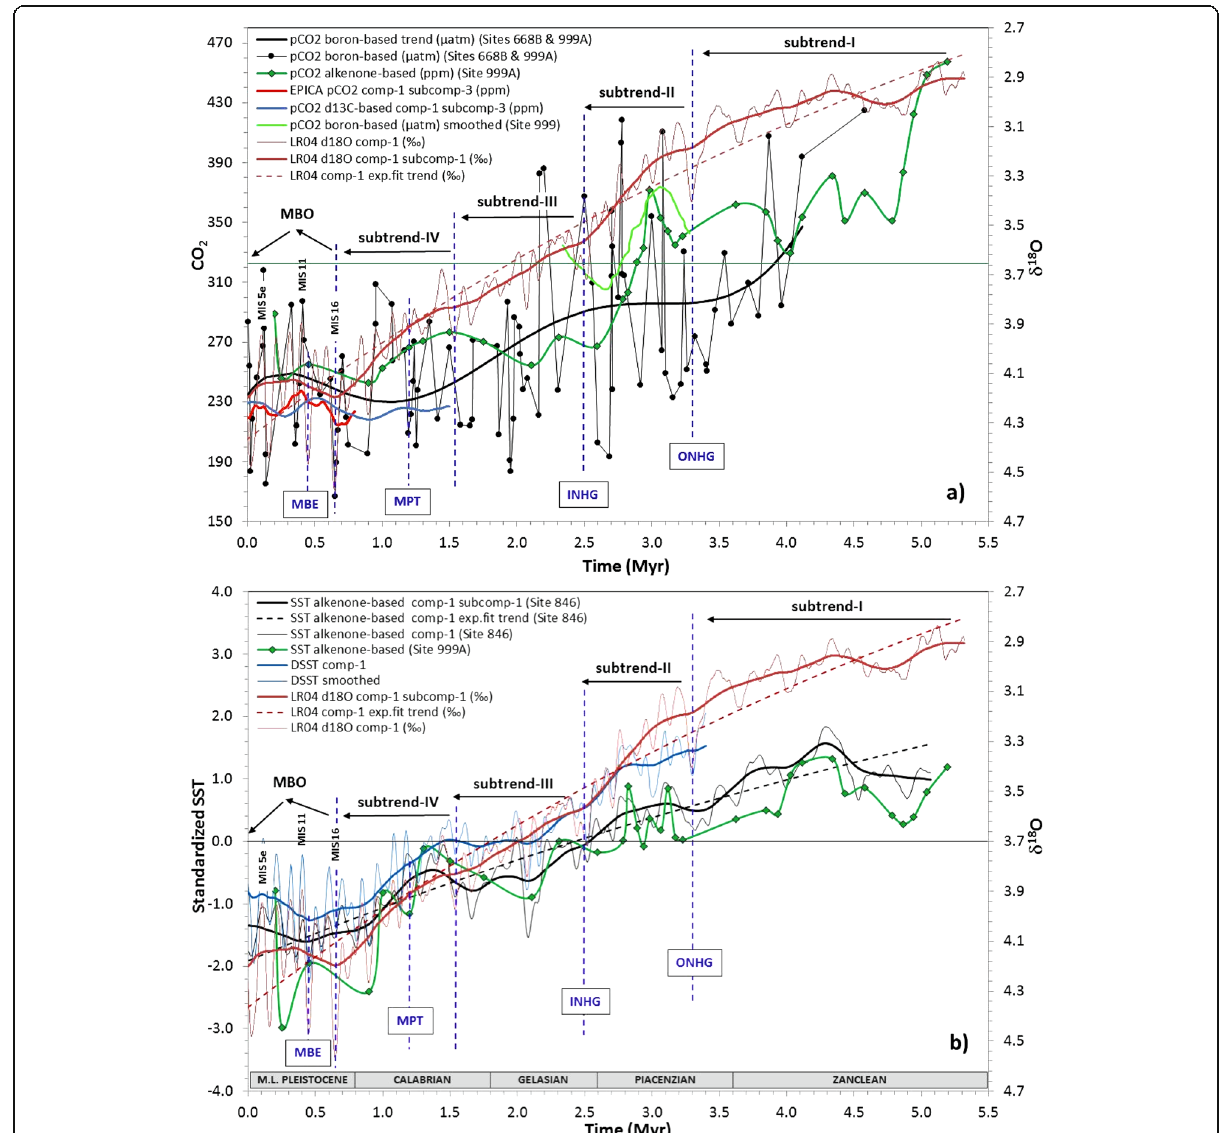
Fig. 14 Comparison over time of the long-term trend components of δ 18 O and the a pCO 2 and b SST proxies. Composite atmospheric boron-based pCO 2 proxy from ODP Sites 668B-999A (Hönisch et al. 2009; Bartoli et al. 2011), atmospheric alkenone-based pCO 2 and SST proxies from ODP Site 999A (Seki et al. 2010), alkenone-based SST proxy from ODP Site 846 (Herbert et al. 2010b), EPICA pCO 2 record (Berger et al. 2016), δ 13 C-based pCO 2 proxy (Lisiecki 2010b), LR04 δ 18 O stack (Lisiecki and Raymo 2005b), boron-based pCO 2 proxy from ODP Site 999 and global Δ SST stack (Martinez-Boti et al. 2015). The horizontal lines are the Plio-Pleistocene average of pCO 2 alkenone (ODP Site 999A) and the standardized mean of the SST. All records are plotted on their own age